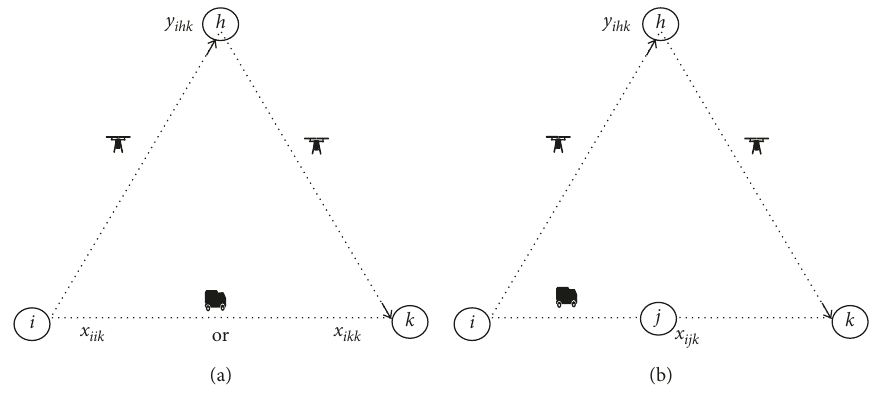
Figure 5: Truck and one-drone problem depiction: (a) truck option 1 and (b) truck option